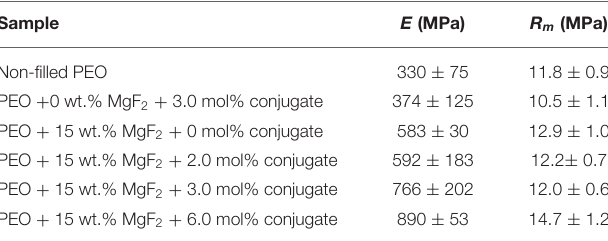
TABLE 2 | Young’s moduli and tensile strengths of in situ mechanical tensile testing experiments. Sample Non-filled